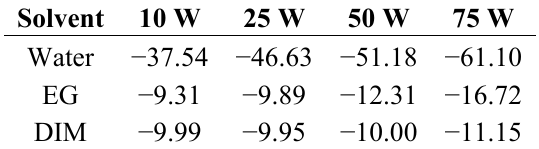
Table 8. Spreading parameter (Δ W , mN/m) of pp–GT thin